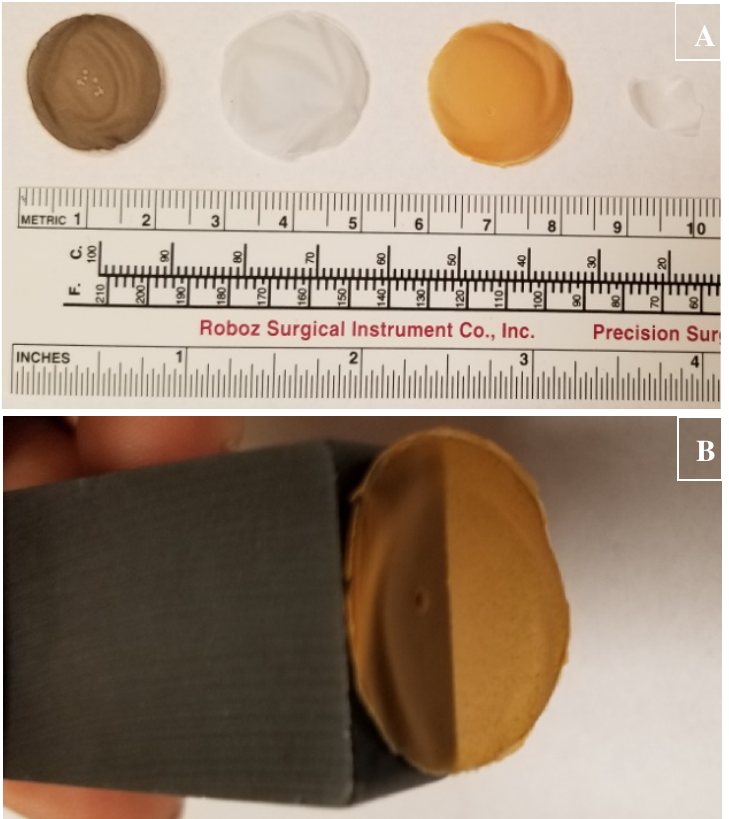
Figure 4. Cellulose matrices for materials integration. Panel ( A ) cellulose matrix at the macroscale, showing from left to right, cellulose biohybrids incorporating CuONPs, CuHARS, Fe 2 O 3 NPs/CuHARS, and cellulose alone, respectively. Metric scale below the matrix discs indicates a diameter of approximately 2 cm for each disc. The 4th sample (rightmost sample) is a fragment of the constructed cellulose matrix alone. Panel ( B ) magnetic susceptibility of materials incorporating Fe 2 O 3 NPs/CuHARS. Cellulose matrix sample incorporating susceptible Fe 2 O 3 NPs is suspended by a permanent bar magnet; the diameter of disc is same as shown in panel ( A ) (=2 cm).